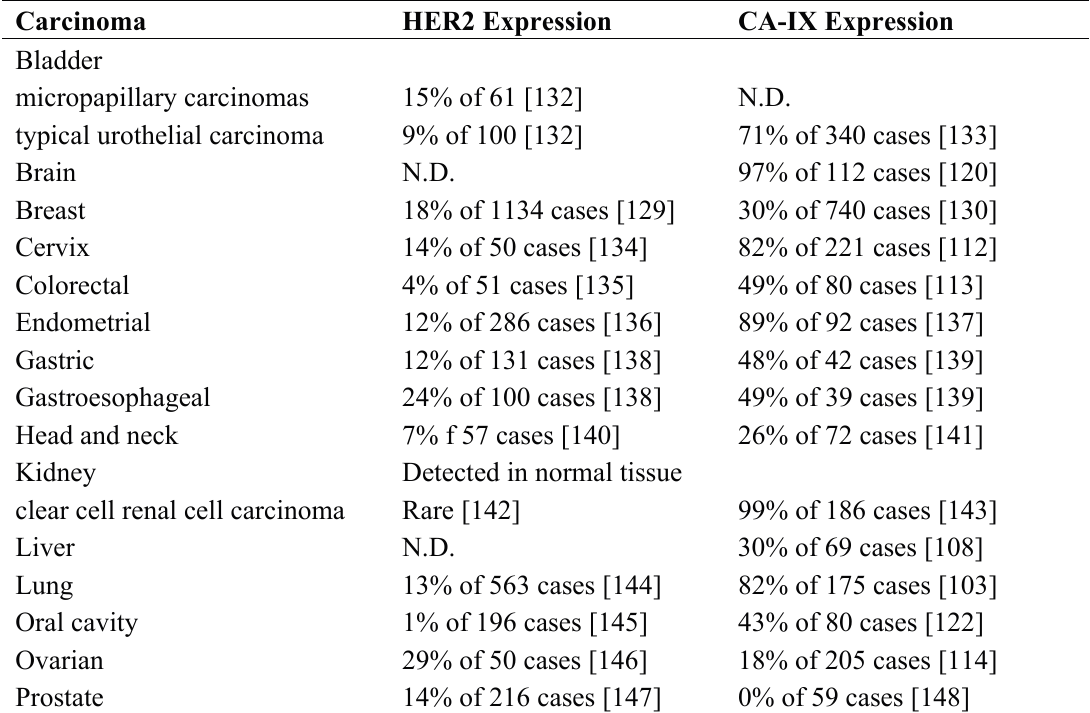
Table 1. Examples of tissue expression of HER2 and CA-IX in various